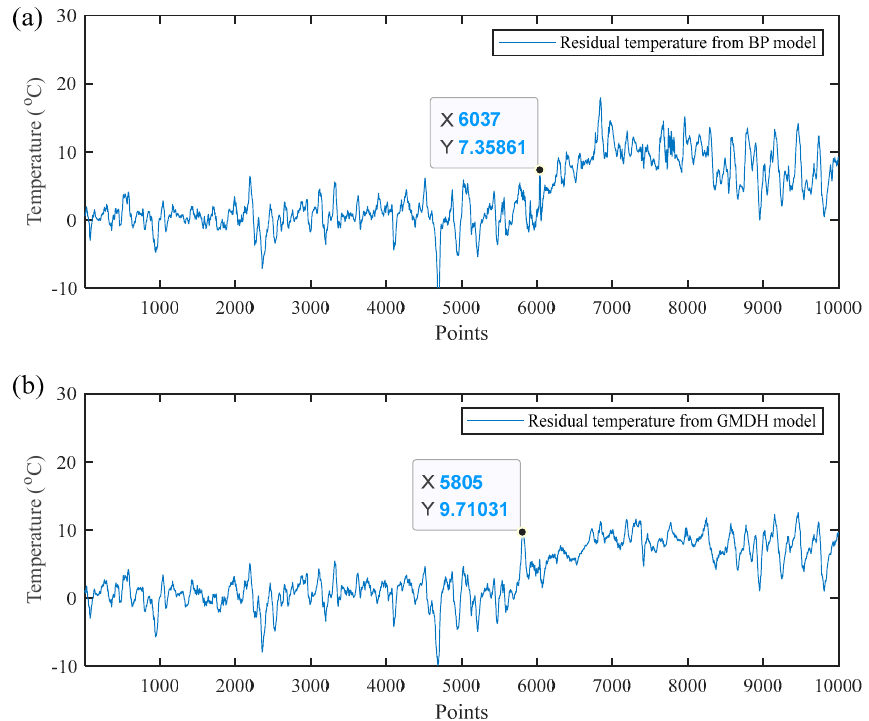
Figure 17. Residual temperature of the gearbox bearing. ( a ) Residual temperature from a BP model, ( b ) Residual temperature from a GMDH model. Table 2. The comparison of calculation